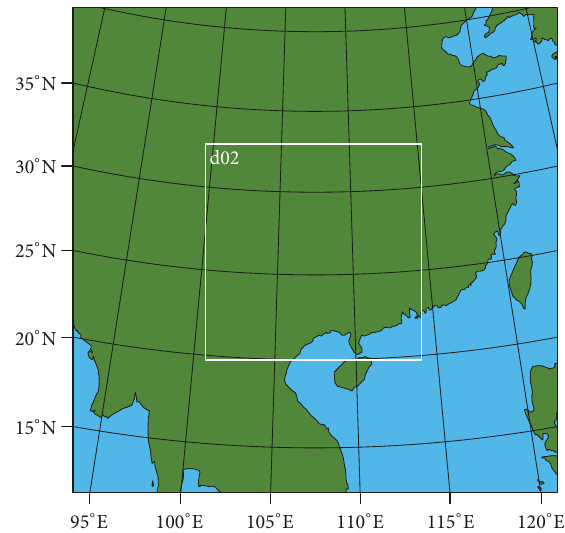
Figure 1: Location of study area and grids used in the MCC simu-